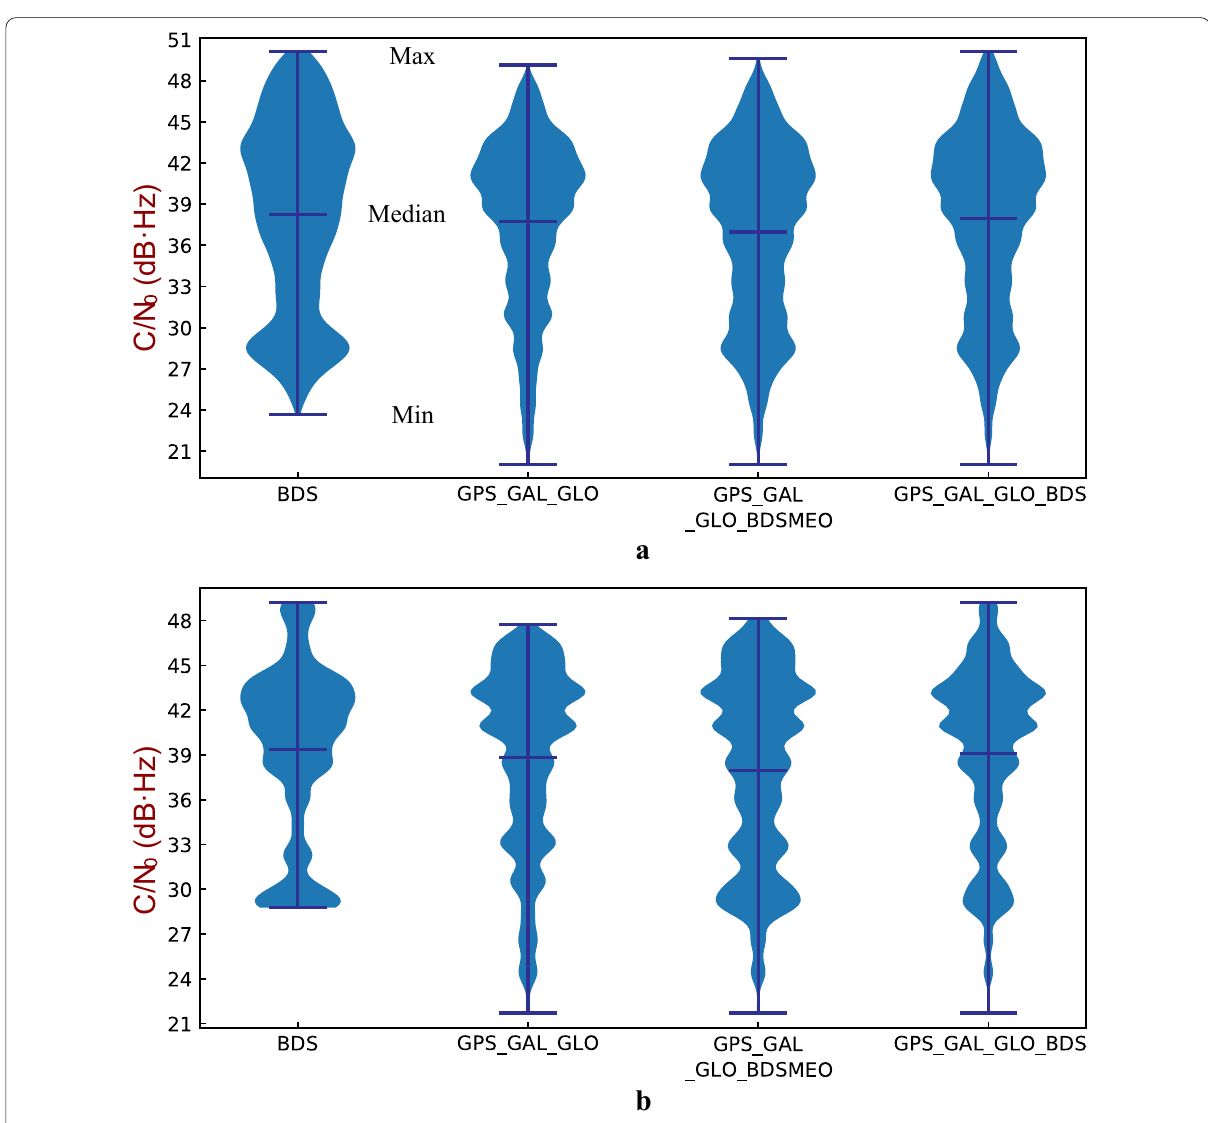
Fig. 9 The received power distribution of different orbits under different scenarios: a SSTO; b GEO